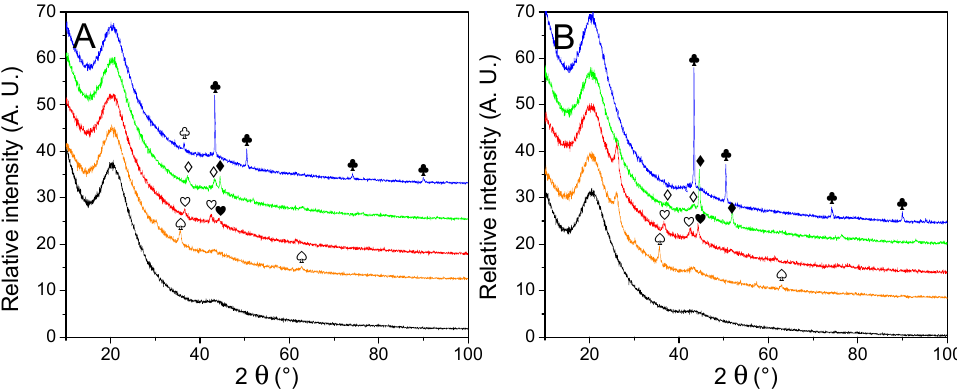
Figure 3. PXRD patterns of non-impregnated GN ( A ) and G2N ( B ) matrixes (black) decorated with Fe (orange), Co (red), Ni (green) and Cu (blue) nanoparticles. Crystalline structures are marked for Fe ( ♠ ), Co ( ♥ ), Ni ( ♦ ), Cu ( ♣ ). Respective oxides are indicated with empty symbols ( ♤ ♡♢ ♧ ). A possible graphite species is marked for G2N Fe and G2N Co (  ). ). A possible